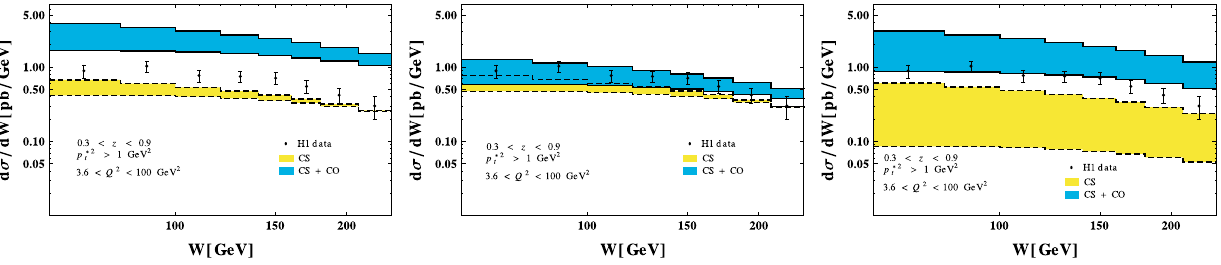
Fig. 11 The differential cross sections for the J /ψ production in DIS with respect to W . The experimental data are taken from Ref. [50]. The l.h.s., middle, and r.h.s. plots correspond to the LDMEs taken in Refs. [28,30,41],